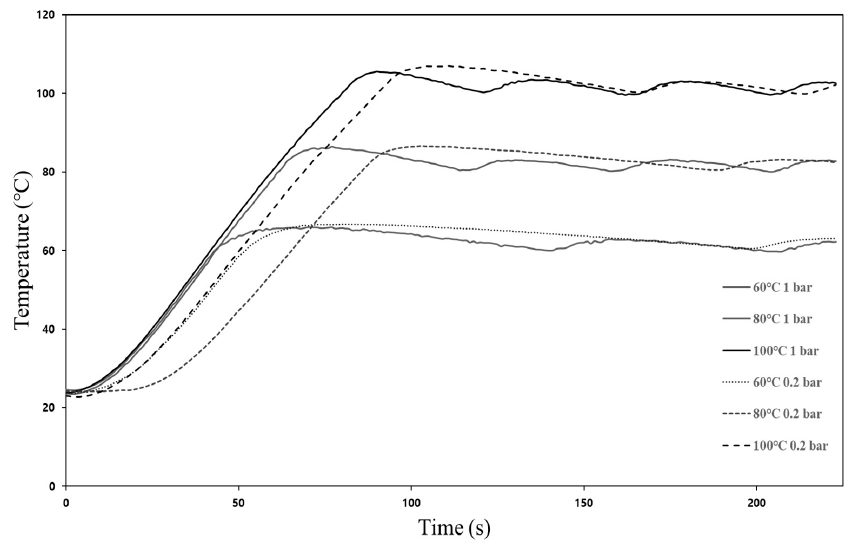
Figure 8. Figure 8. The temperature profiles of sprout barley powder samples treated by different heating conditions. Table 2. Changes in CIE values and total color difference of sprout barley powder treated by dif- ferent heating conditions.